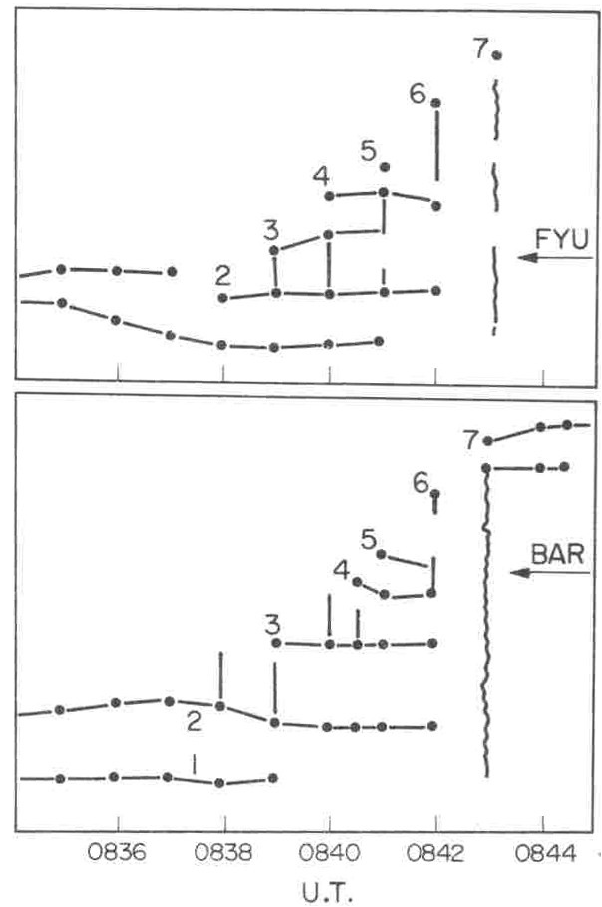
Figure 24. Distribution of discrete auroras at Fort Yukon and Point Barrow meridians during the substorm on 13 February 1958 (Sergeev and Yahnin,